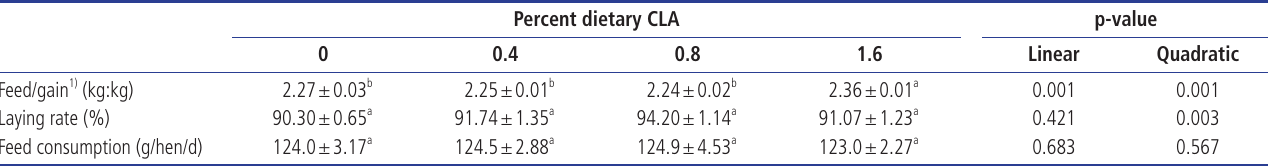
Table 3. Effects of CLA on performance of laying hens